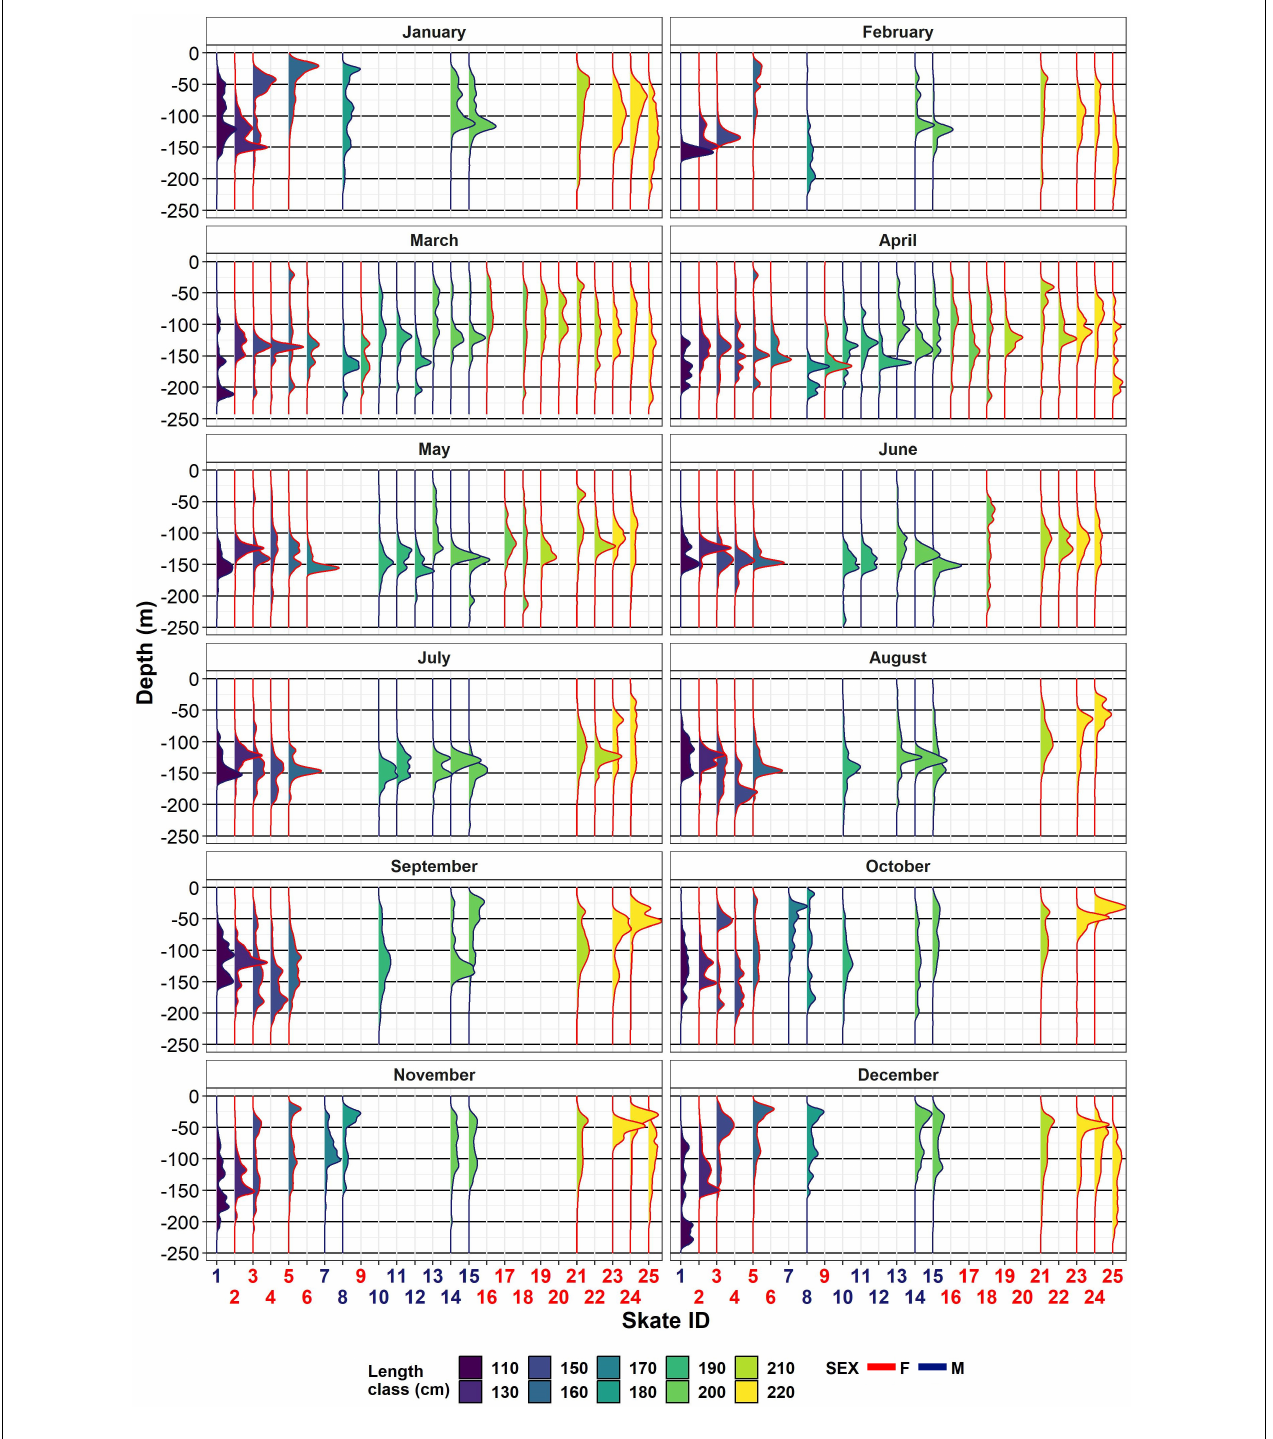
FIGURE 3 | Individual monthly depth distributions. The x -axis shows the skate ID (staggered to ease visualisation) as in Table 1 . Length class is colour-coded to facilitate interpretation. Sex is also colour-coded, both in the x -axis label and in the distribution outline: females are outlined in red and males outlined in blue.